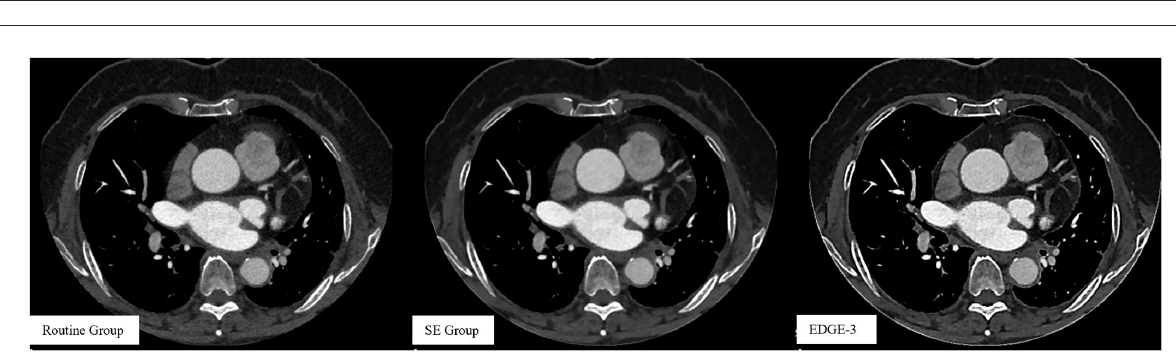
FIGURE5 Images without using a combination of image filters in the routine group and images after using a combination of image filters in the SE (smooth 3D + and edge-2) and Edge-3 (smooth 3D + and edge-3)